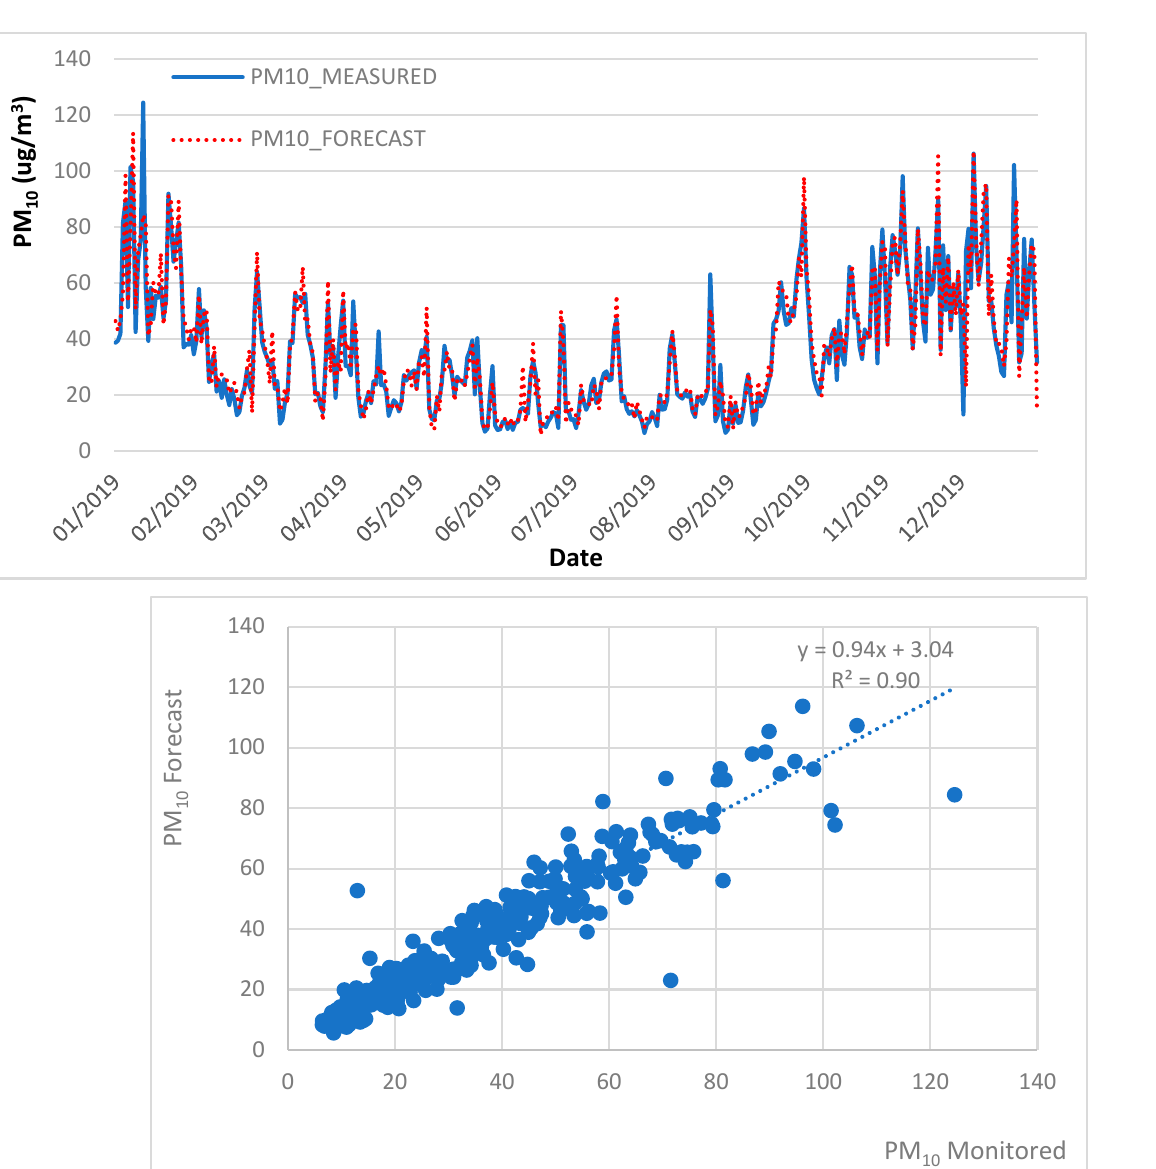
Figure 1. Observed and predicted PM 10 concentrations using MLR for the year of